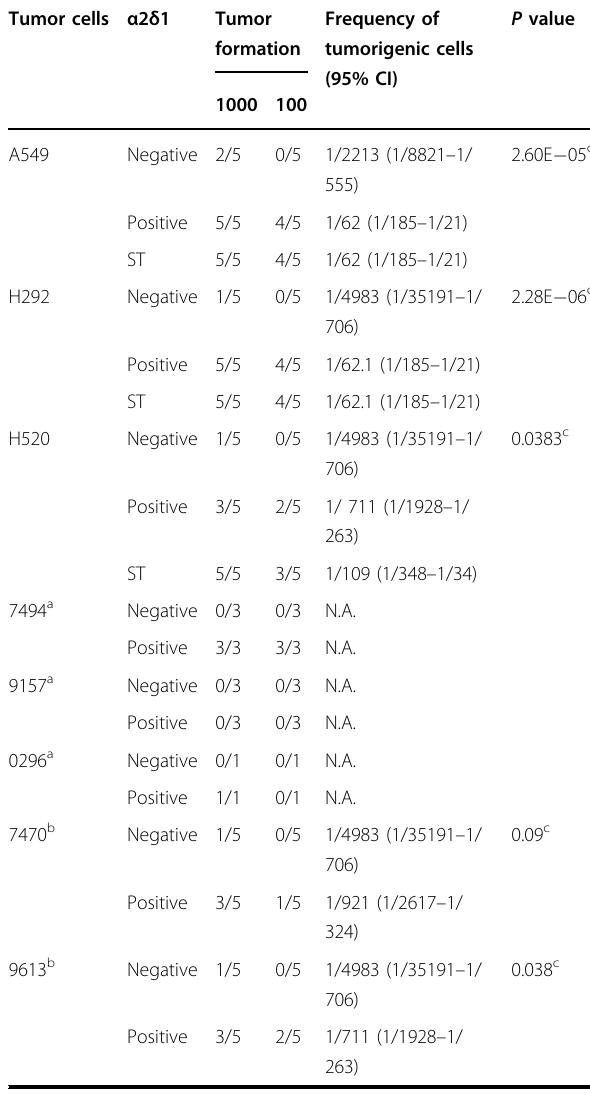
Table 1 The tumorigenicity of α 2 δ 1 + and α 2 δ 1 − cells of NSCLC in NOD/SCID